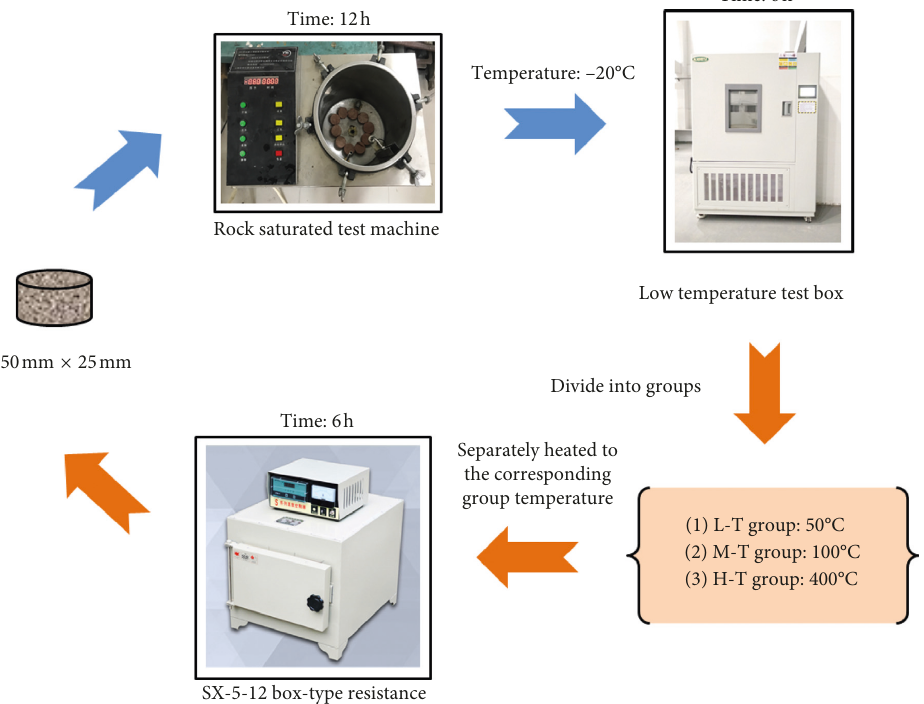
Figure 3: H-C cycles test procedure.